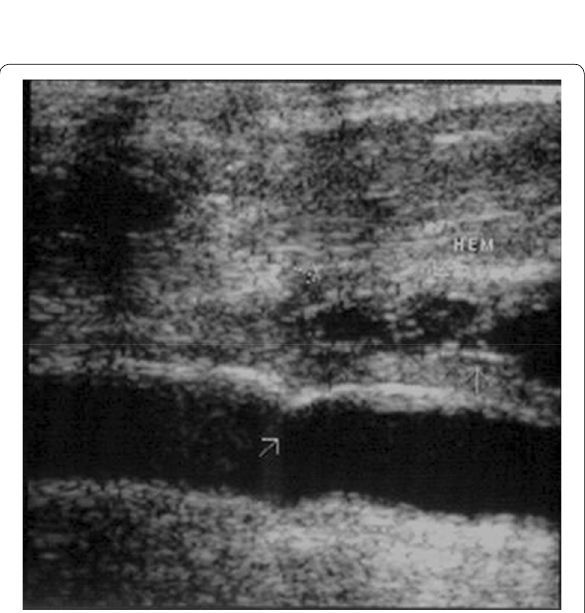
Fig. 9 B mode of carotid artery after a penetrating wound caused by a knife: soft tissues edema and irregularity of the anterior wall of the carotid artery is clearly observed